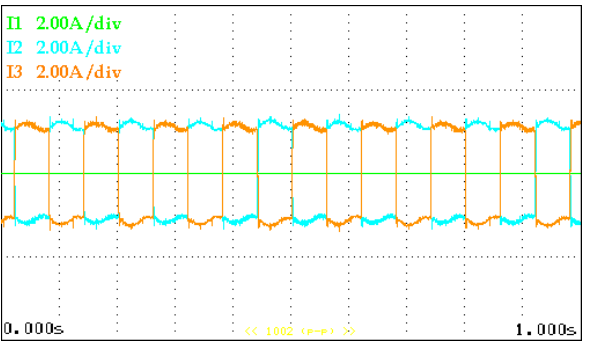
Figure 14. Currents in the BLDC motor operating under phase fault condition with current reduc- tion strategy.